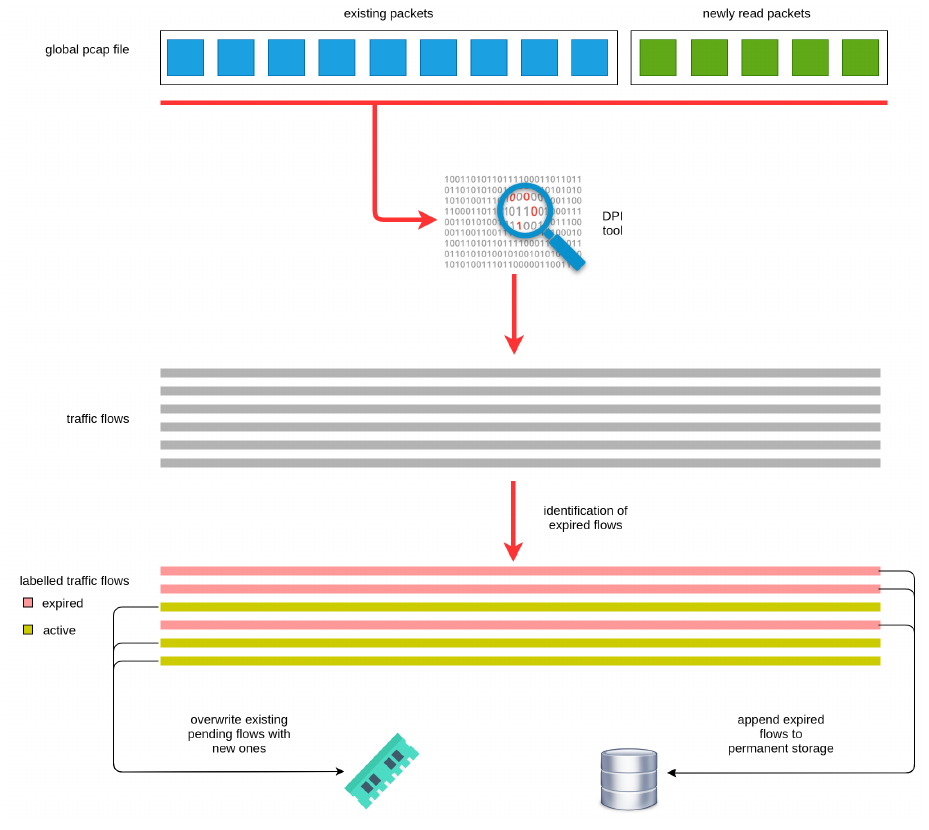
Figure 4. Traffic flows